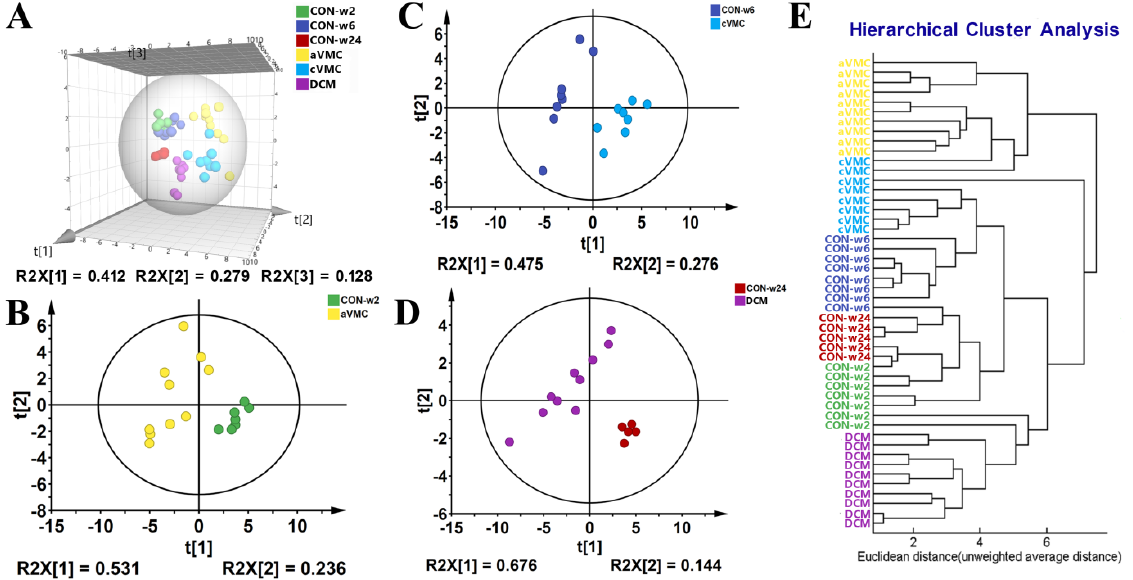
Figure 1. Multivariate statistical analyses for 1D 1 H − NMR spectra recorded on the six groups of mouse cardiac tissues (CON − w2, CON-w6, CON − w24, aVMC, cVMC and DCM): ( A ) PCA scores plot for the six groups; ( B – D ) PCA scores plots for aVMC and CON − w2 ( B ); cVMC and CON − w6 ( C ); DCM and CON − w24 ( D ); ( E ) HCA clustering tree for the six groups. Each point represents a sample derived from an individual mouse.